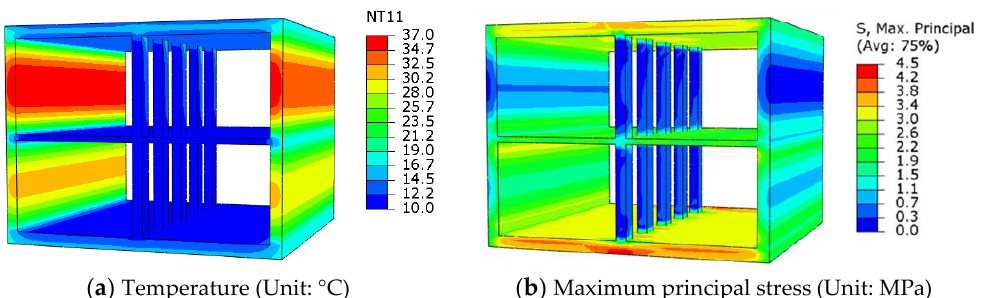
Figure 6. Temperature and maximum principal stress distribution of a concrete structure in a metro station at the end of the construction period.